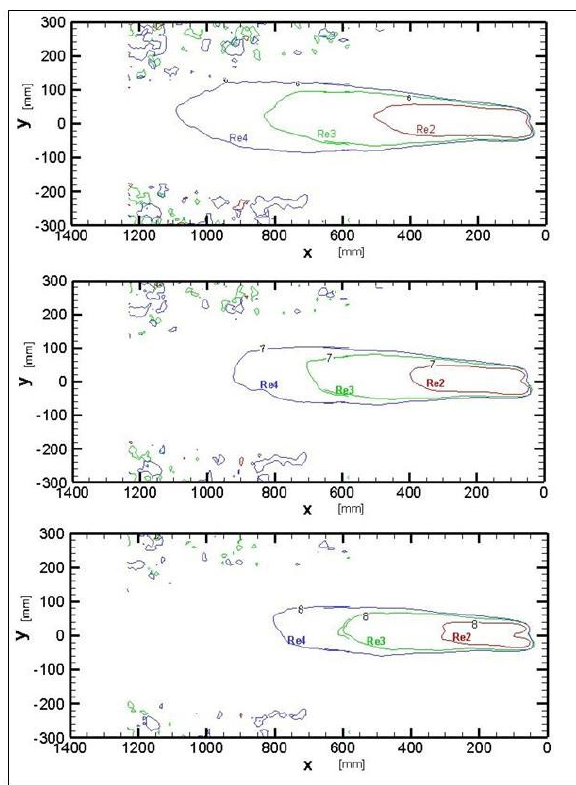
Fig. 5 . The lines with the same value velocity vector axial component Vx at the air flow rate 385m3/h and for the 60 angle vanes.